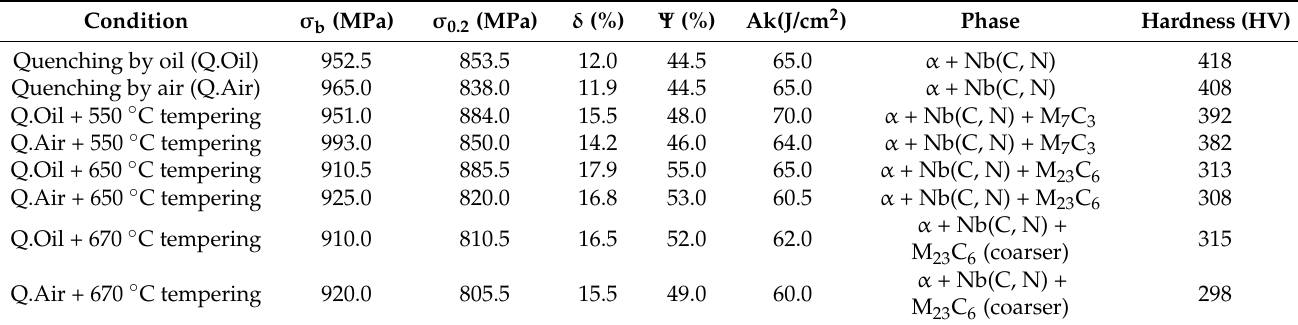
Table 8. Comparison of tensile properties, hardness and the subsequent phases under different heat treatment processes. Condition σ b (MPa) σ 0.2 (MPa) δ (%) Ψ (%) Ak(J/cm 2 ) Phase Hardness